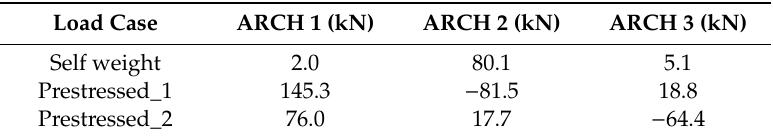
Table 9. Forces on arches with crosspieces of 120 mm.